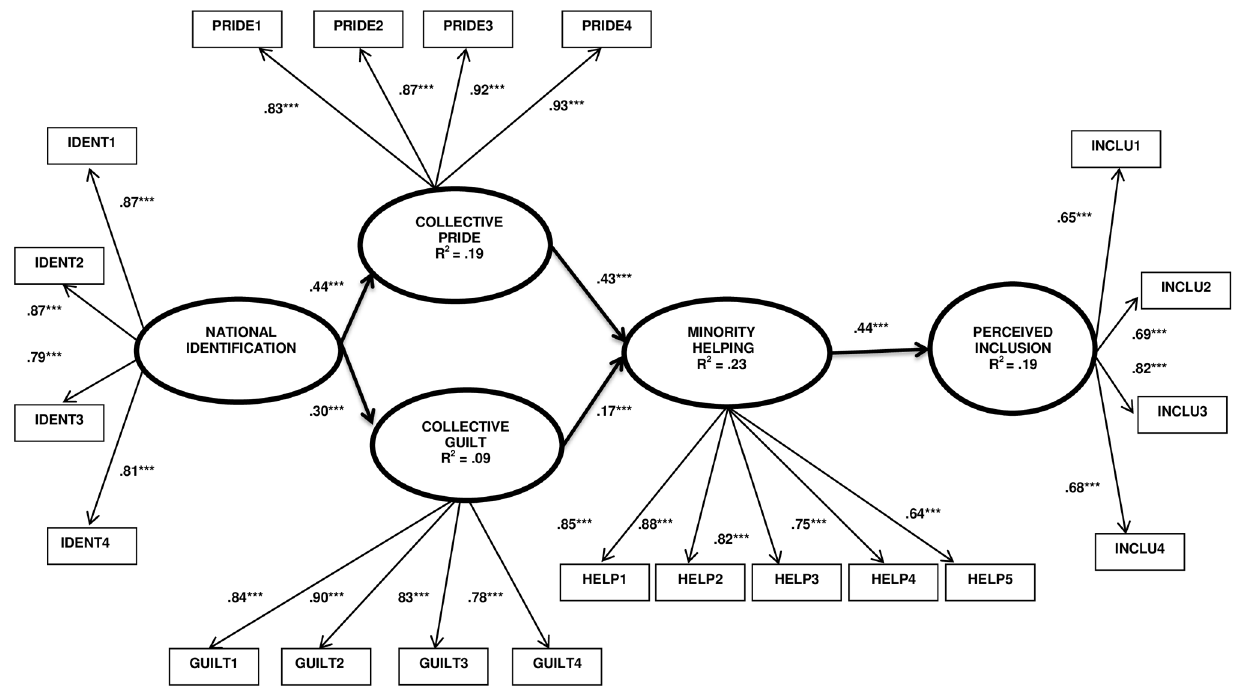
Figure 1. Full model of the relationships among perceived inclusion, minority helping, collective pride, collective guilt, and national identification. Numbers in the model are standardized path